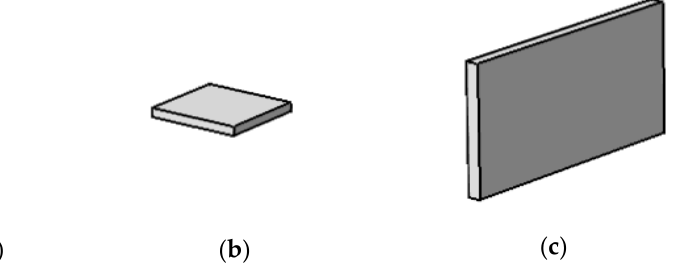
Figure 9. Simulation example diagram of three types of wear particles. ( a ) Abrasion; ( b ) Rolling fatigue; ( c ) Severe sliding wear. Table 4. Geometric parameter setting of simulated wear particles.